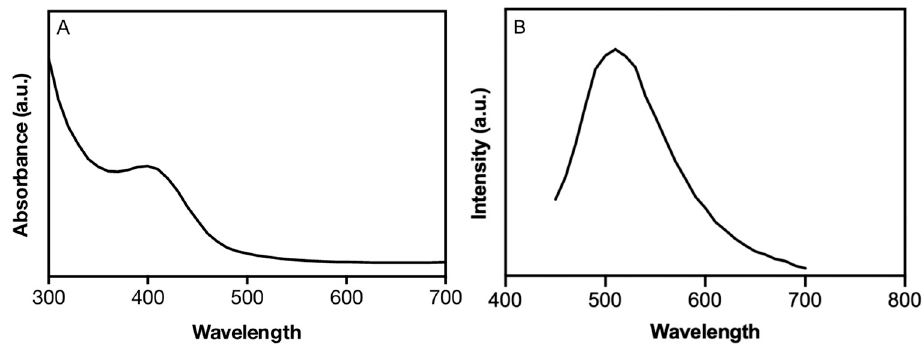
Figure 1. Spectroscopic properties of Cu 2 S NPs. ( A ) Absorbance and ( B ) fluorescence spectra of Cu 2 S NPs ( ʎ exc = 410 nm). Based on the emission spectra, a full width at half maximum (FWHM) of 103.22 nm was determined.